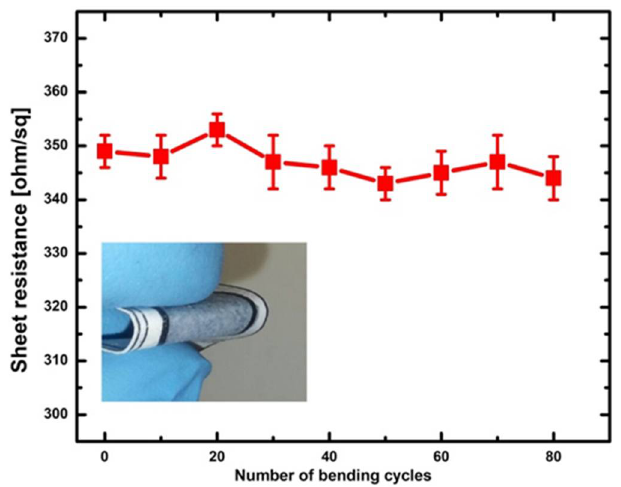
Figure 4. Sheet resistance of the anodic chamber vs. the number of bending cycles.